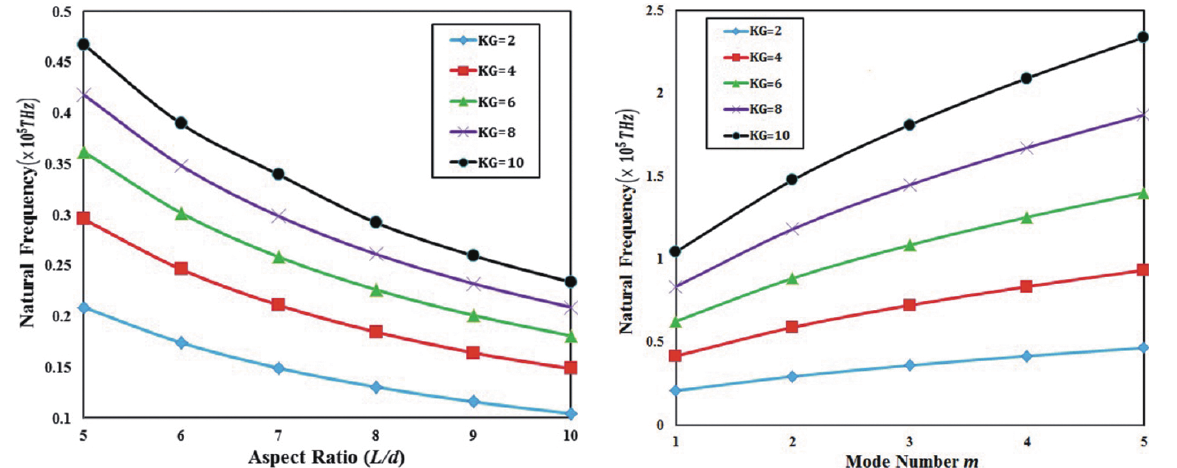
Fig. 7. The effect of shear modulus parameter K G on natural frequency of a short-SWCNT for different aspect ratio L/d , ( K W = 10 2 N/m 2 , m = 1 , μ = 0 . 5 ).